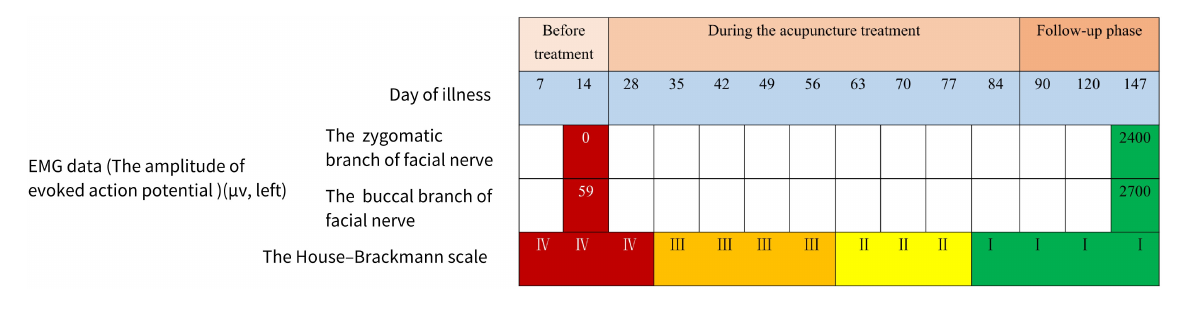
FIGURE4 The EMG data and the House–Brackmann scale changed when the treatment